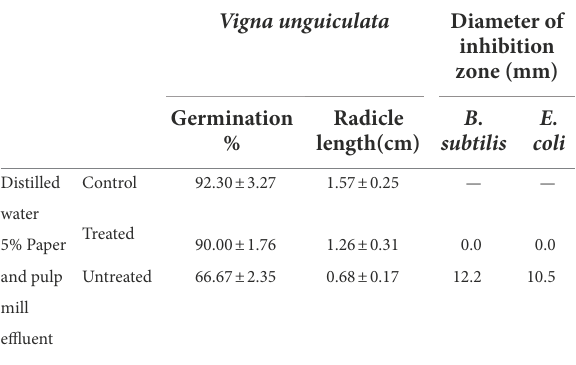
TABLE 2 Toxicity of industrial wastewater before and after treatment by